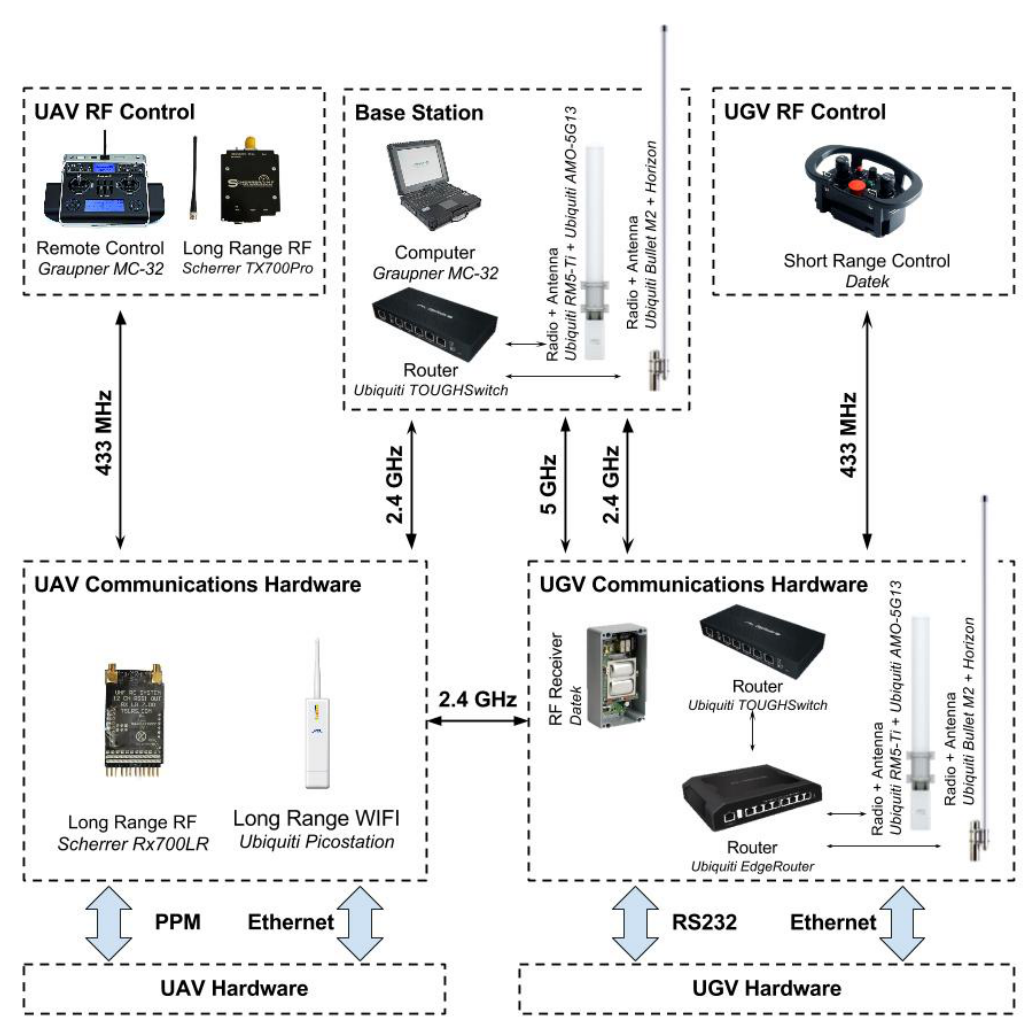
Figure 12. Communications hardware architecture for both the UAV and UGV. Black arrows represent the wireless connections between interaction devices (e.g., remote RF controllers), the base station, UAV and UGV. Blue arrows represent the wired connections between the UAV’s and UGV’s communications and control hardware (see Figures 6 and